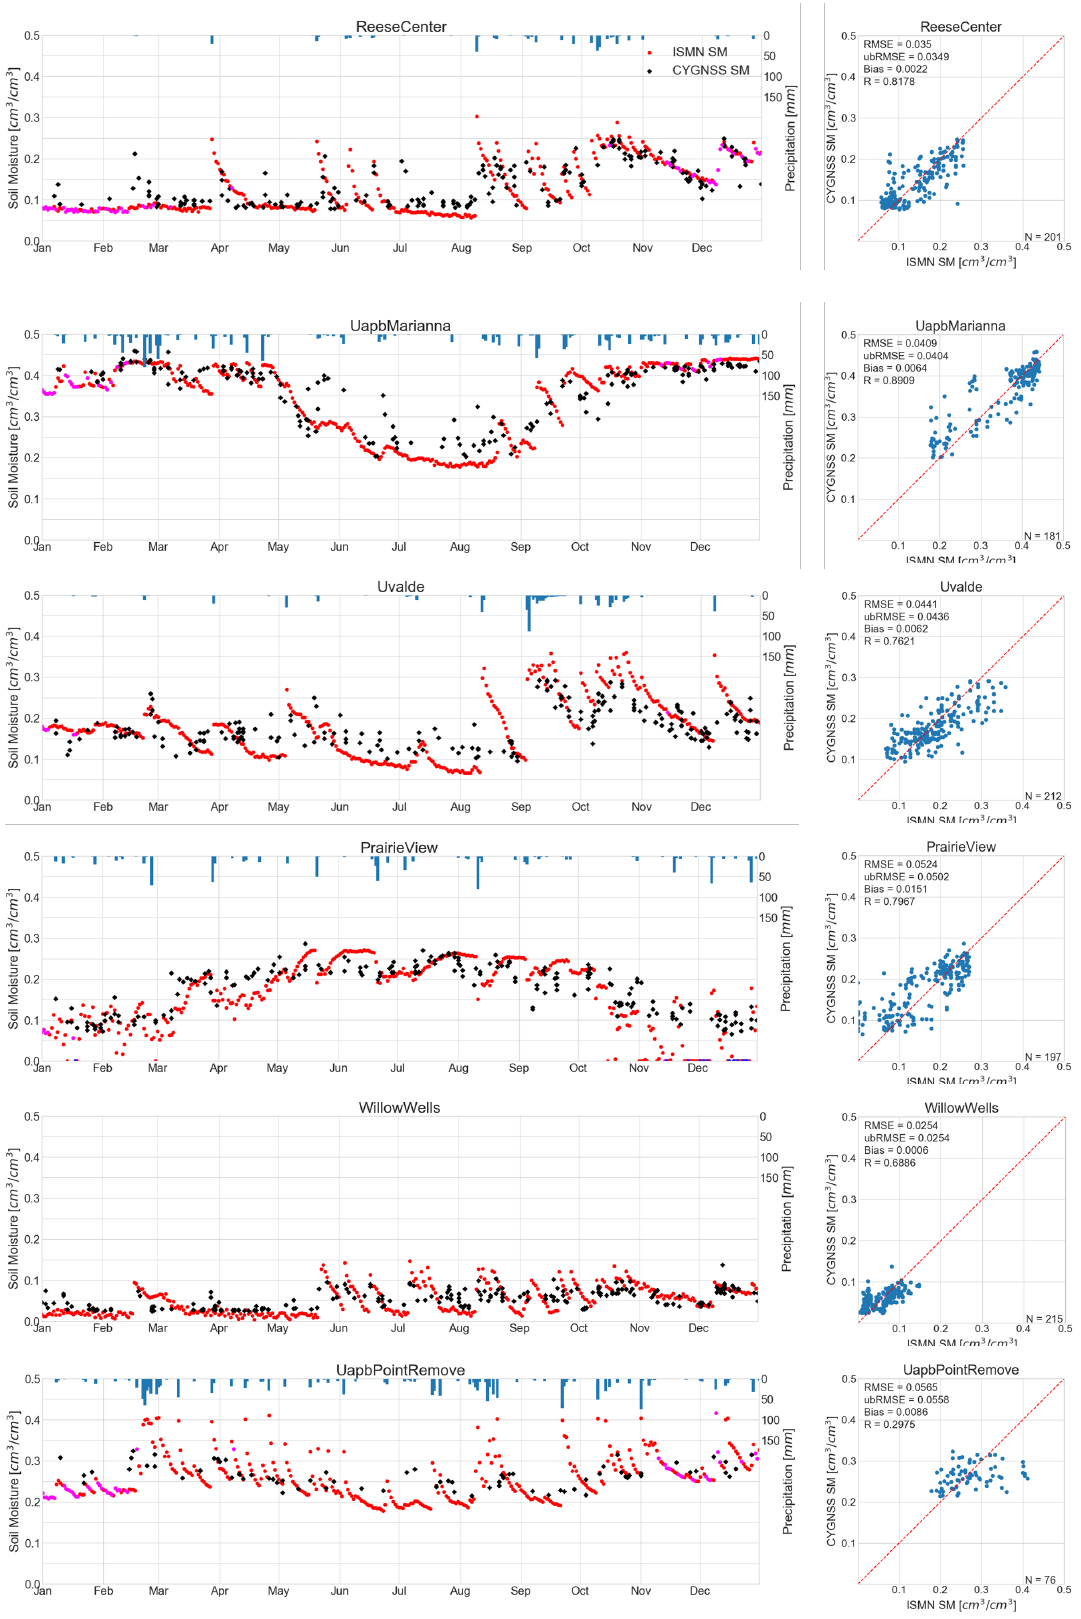
Figure 10. SM retrievals for year 2018. In situ SM data are color-coded such that magenta and blue circles correspond to days with freeze temperatures and invalid data, respectively. Scatter plots are also